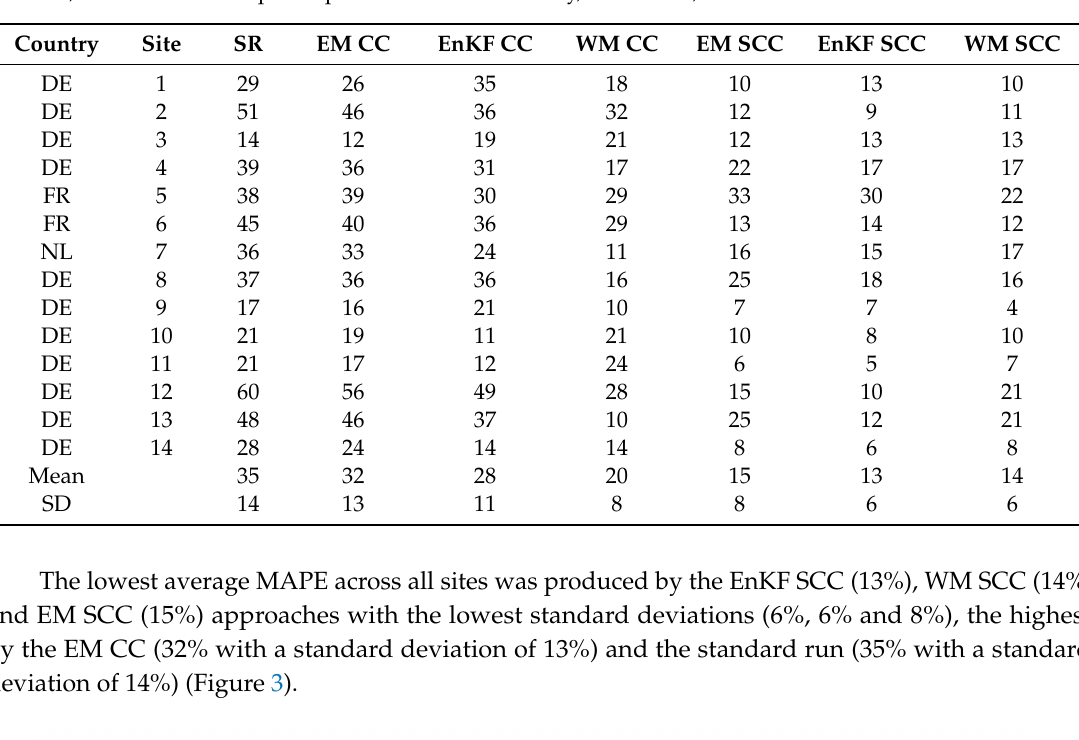
Table 5. Mean absolute percentage (MAPE in %) results for total aboveground biomass. SR: Standard